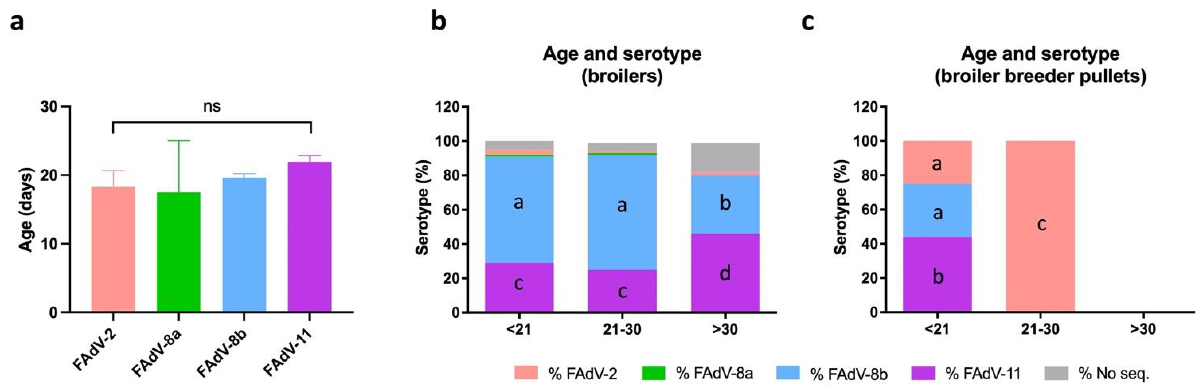
Figure 6. Distribution of FAdV serotypes based on age in meat-type chickens between 2011 and 2021 in Spain. ( a ) Mean age of IBH-positive broilers and broiler breeder pullets based on FAdV serotype. Statistical significance was declared at p ≤ 0.05. ( b ) Percentage of FAdV serotypes per age group in broilers. ( c ) Percentage of FAdV serotypes per age group in broiler breeder pullets. Different letters designate statistical significance in Fisher’s exact test ( p ≤ 0.05).